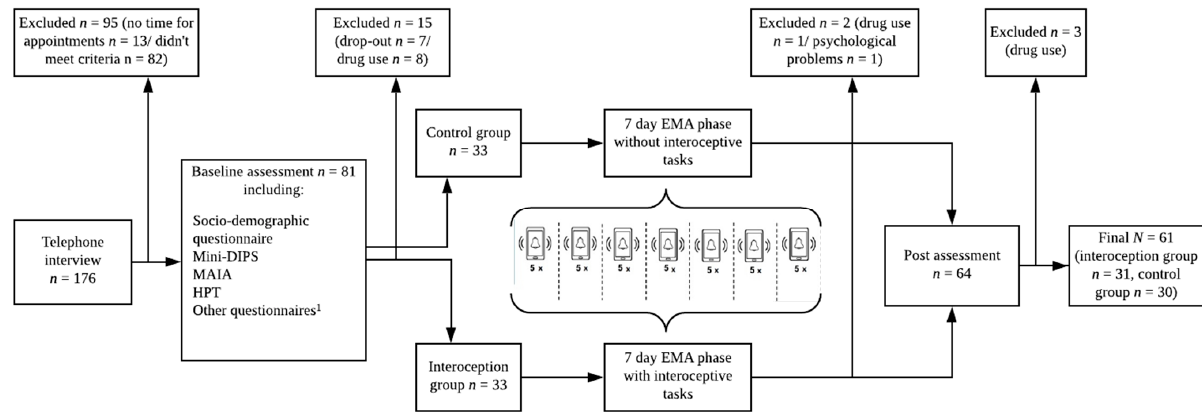
Figure 1. Study Procedure. 1 Other questionnaires, which have not been analyzed for this study; Mini-DIPS = structured clinical interview for ICD disorders; MAIA = Multidimensional Assessment of Interoceptive Awareness; HPT = Heartbeat Perception Task; EMA = Ecological Momentary Assessment. Baseline assessment was identical to post assessment.